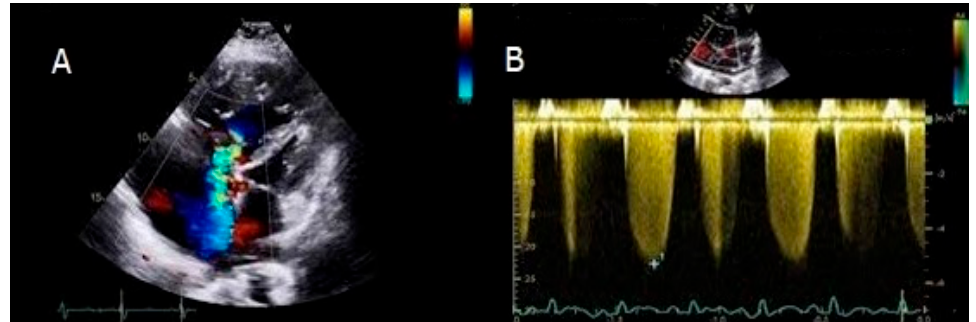
Figure 1. Apical four chambers view showing a very dilated right ventricle and severe tricuspid valve regurgitation. The interventricular septum bulged toward the left ventricle (panel A ). The RVSP was significantly increased (panel B ).